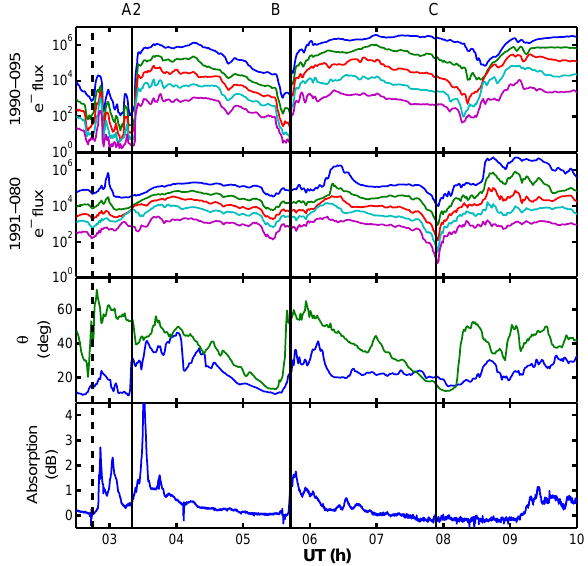
Fig. 5. LANL, GOES and Gillam riometer data on the 18 April 2002 from 02:30 UT to 10:00 UT. The top two panels show the elec- tron fluxes from two of the LANL satellites near to the CANOPUS riometers; the energy channels are described in Fig. 3 caption. The third panel shows the elevation angle, θ , of the geomagnetic field recorded by the GOES 8 (blue line) and GOES 10 (green line). The bottom panel shows the auroral absorption measured by the Gillam riometer. The vertical black lines (marked A, B and C) demonstrate the approximate times of particle injections. The dashed, vertical black line notes the position of an additional